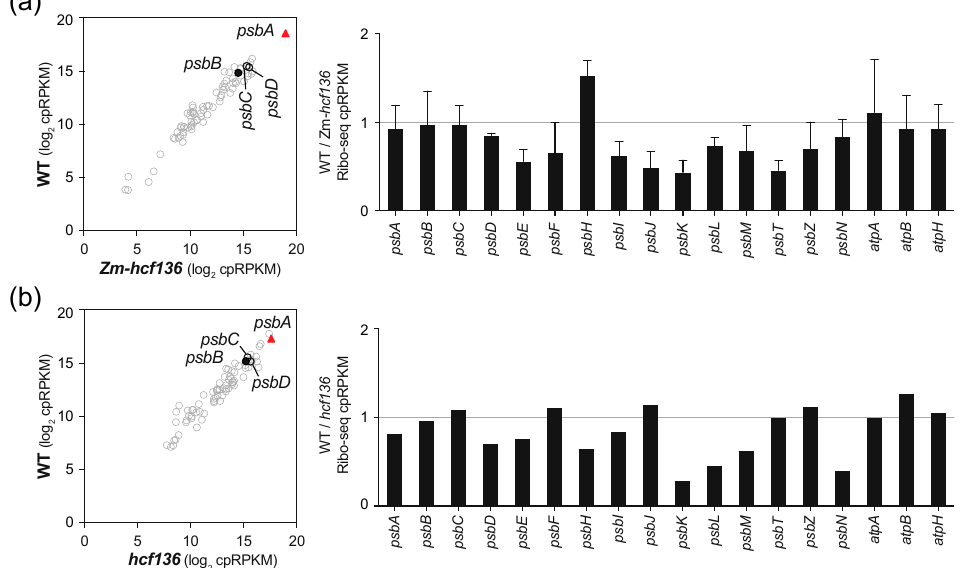
Figure 5. Ribo-seq analysis of hcf136 mutants in maize and Arabidopsis. Symbols and nomenclature are as described in Figure 2. ( a ) Comparison of ribosome footprint abundance for chloroplast genes in Zm- hcf136 mutants to that in their phenotypically normal siblings. Results for a biological replicate are shown in Figure S1d. The bar graph shows the average of the two replicates (+/– SD). ( b ) Comparison of ribosome footprint abundance for chloroplast genes in Arabidopsis hcf136 mutants to that in their phenotypically normal siblings.